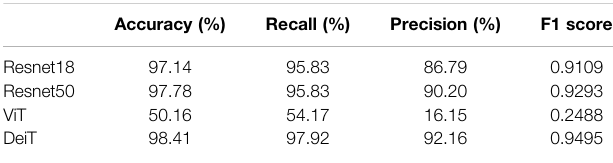
TABLE 6 | Results of case